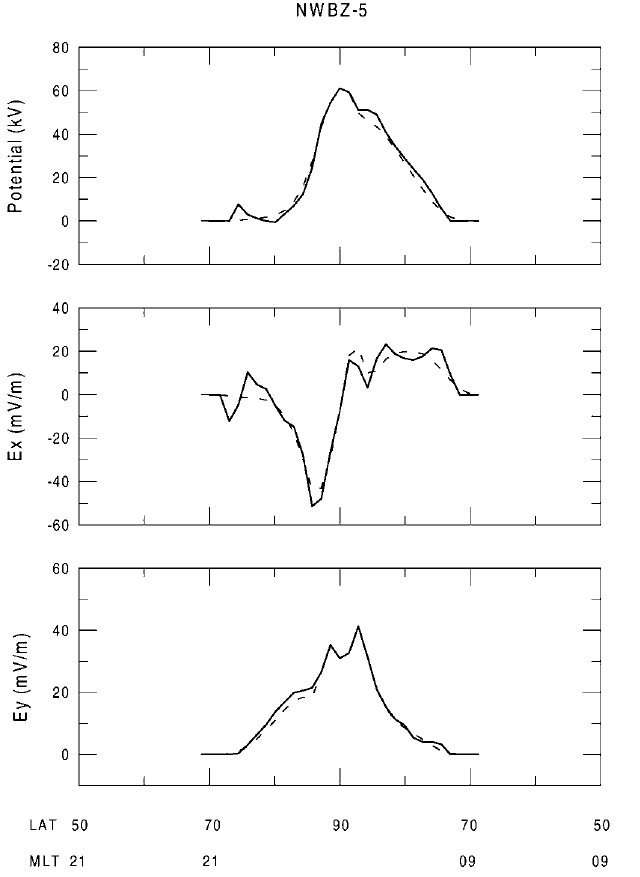
Fig. 2. Profiles of the electric potentials and electric field components ( E x and E y ) in the northern winter polar cap for IMF B x (cid:136) 0, B y (cid:136) 0, B z (cid:136) (cid:255) 5 nT along the MLT meridian 21-09. Solid lines are for the data from the IZMEM/DMSP model, dashed lines represent reconstructed values